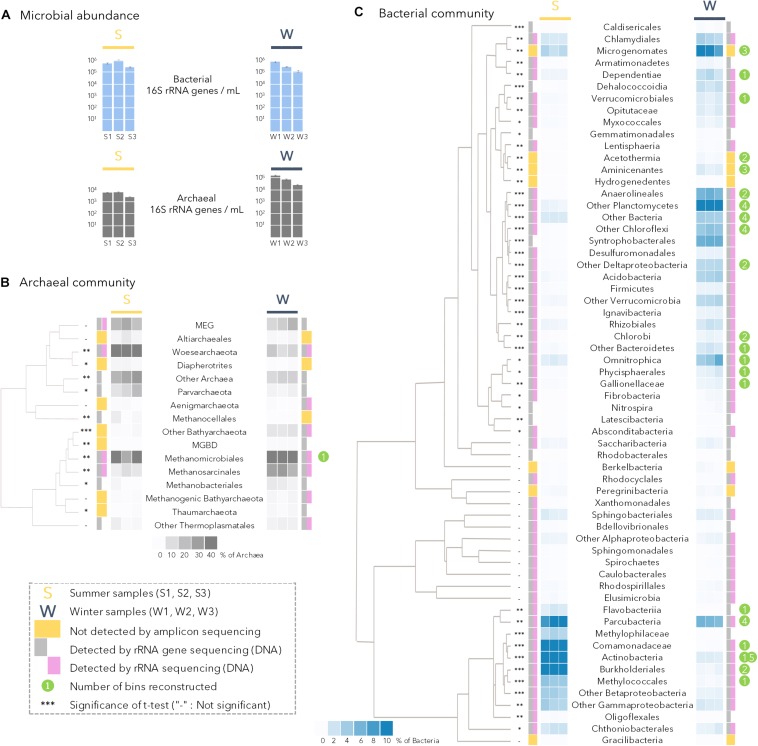
(A) Bacterial and archaeal abundance determined by quantitative PCR in all summer (S1, S2, S3) and winter (W1, W2, W3) samples. (B) Archaeal community composition in summer (S1, S2, S3) and winter (W1, W2, W3) samples. MBGD: Marine Benthic Group B; MEG: Miscellaneous Euryarchaeotal Group. (C) Bacterial community composition in summer (S1, S2, S3) and winter (W1, W2, W3) samples. Heat maps of the relative proportion of microbial lineages are based on 16S rRNA genes from metagenomic dataset. Clustering of the microbial lineage relative proportion (constructed by UPGMA with Euclidian distance on the correlation matrix generated using microbial lineage relative proportions) gather lineages with similar relative proportion in the samples. Gray rectangles (detected by PCR on DNA template) and purple rectangles (detected by PCR on cDNA template) indicates the detection of a given lineage by 16S rRNA (gene) amplicon sequencing whereas lineages with yellow squares were not detected by amplicon sequencing (details in Supplementary Figure 1). Differences in the relative proportion between summer and winter samples were evaluated by t-tests; the significance of the test is presented as: -, not-significant; *p < 0.05; ∗∗p < 0.01; ∗∗∗p < 0.0005. The number of genomic bins reconstructed per lineage is indicated by the green circles.